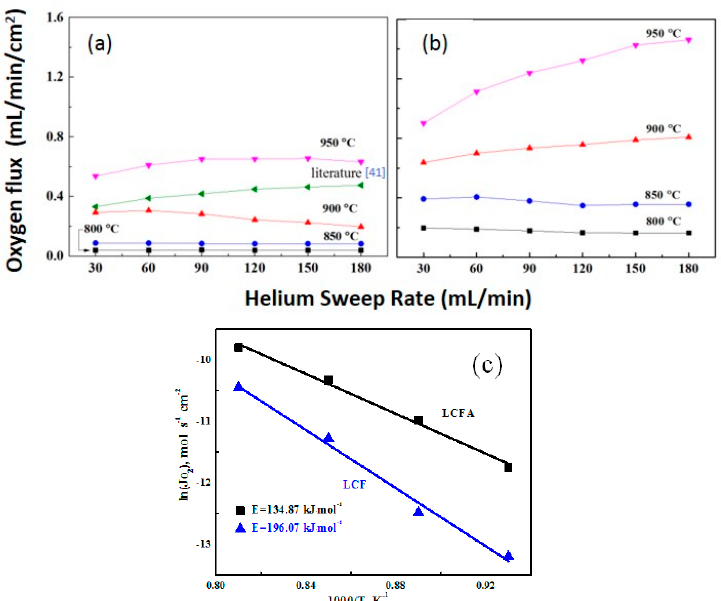
Figure 5. Oxygen fluxes at different operation conditions ( a ) LCF; ( b ) LCFA; and ( c ) Arrhenius plot; air flow rate 100 mL/min.